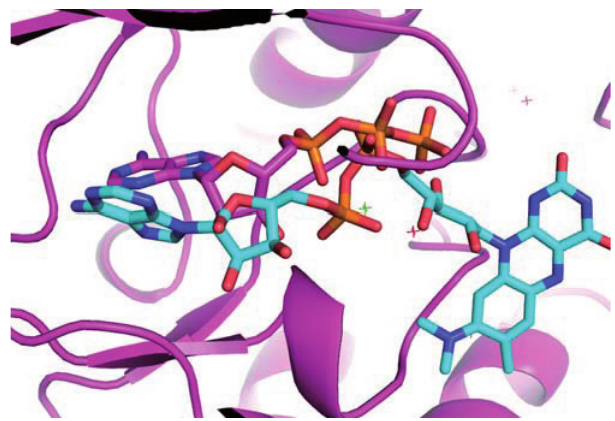
Figure 7. Protein Bub1 (PDB code 3e7e) bound to ATP (in magenta). The riboflavin (RFL) ligand from PDB entry 1d7l (in cyan) is superimposed based on the similarities identified by IsoCleft. This result suggests that the two proteins have a similar arrangement or residues that were conserved throughout evolution to bind the common moieties of ATP and